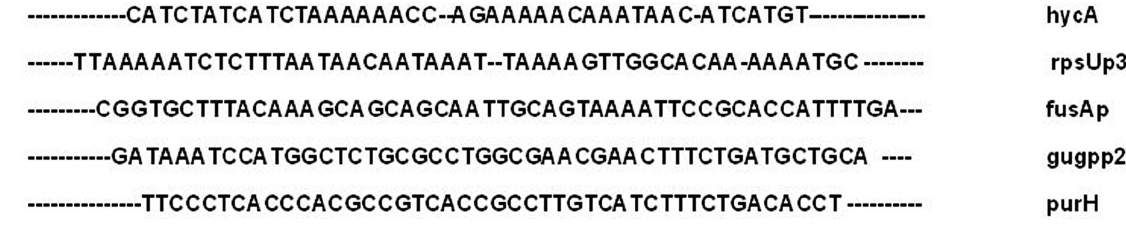
Figure 1 - Examples of promoter sequences aligned by ClustalW